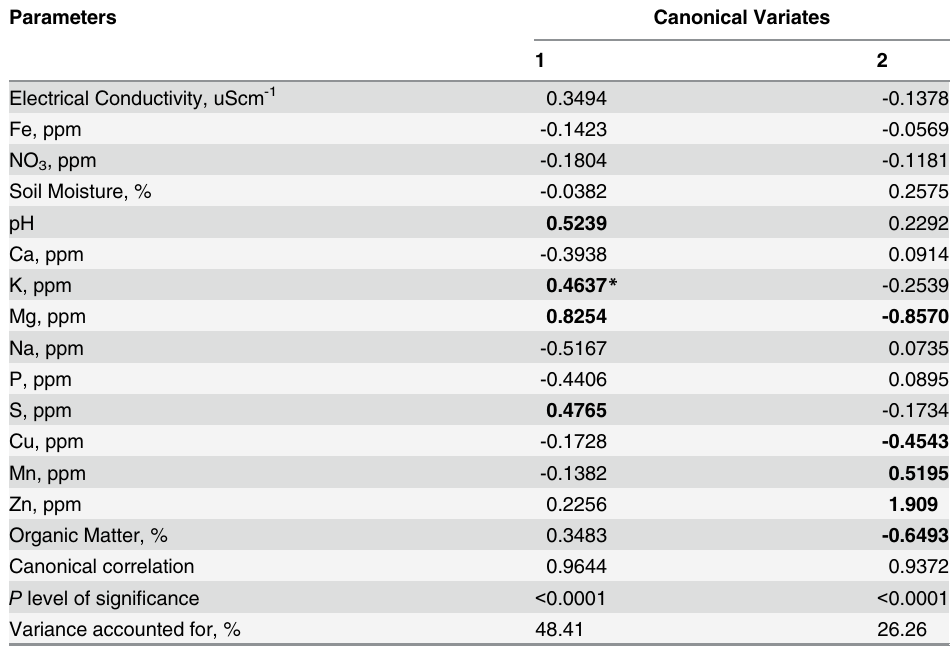
Table 1. Standardized canonical loading coefficients of the first two canonical variates for the 15 soil parameters.